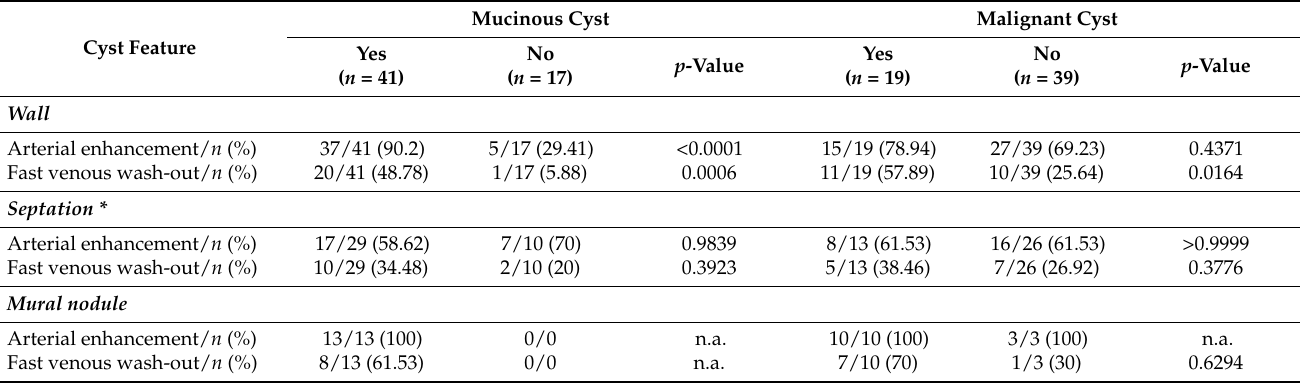
Figure 5. Branch-duct IPMN with mural nodule ( a ) B-mode EUS; ( b ) CH-EUS-FNA from the mural nodule (arrow). Table 2. CH-EUS features: mucinous vs. non-mucinous and malignant vs. non-malignant pancreatic cysts.